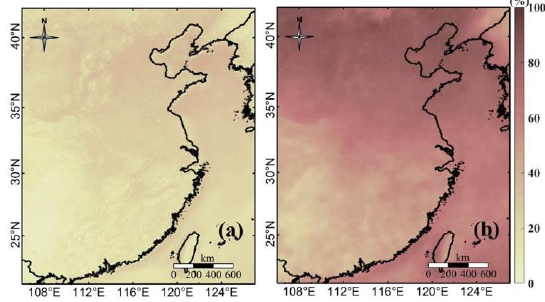
Figure 2 . Spatial distributions of the yearly averaged completeness of (a) the original Himawari/AHI hourly AOD datasets and (b) AOD datasets after NBME